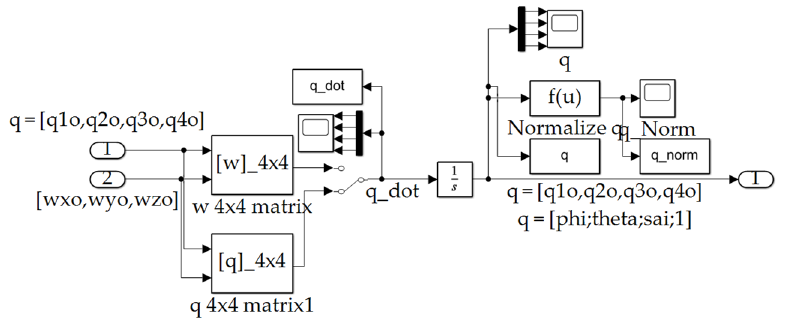
Figure A9. Disturbances’ subsystem depicted in Figure A1.